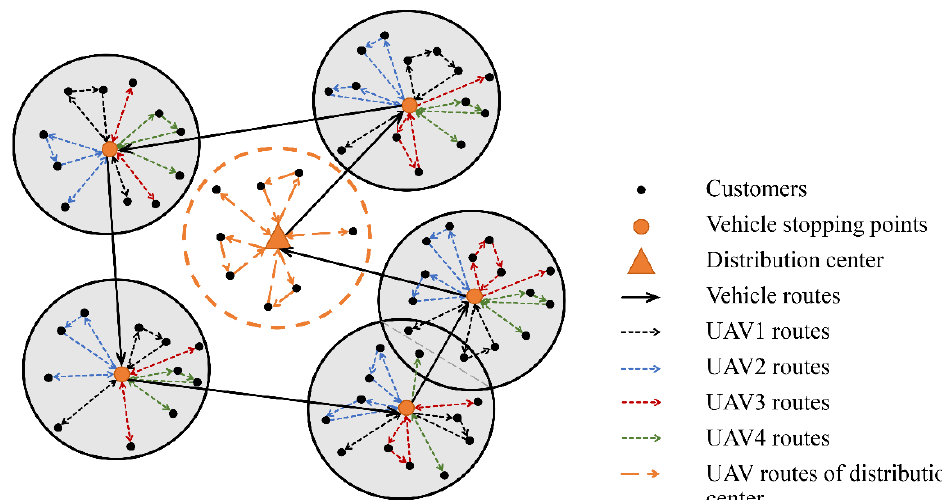
Figure 1. Description of vehicle-assisted UAV